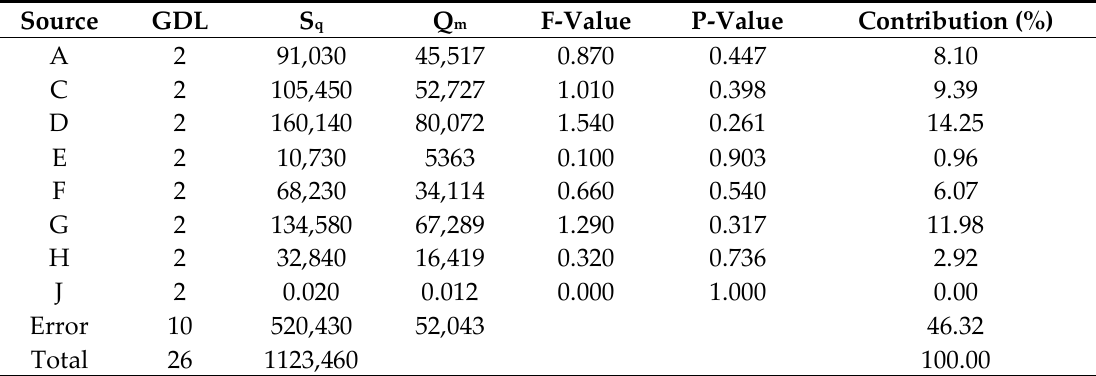
Table 4. ANOVA analysis for bead penetration.